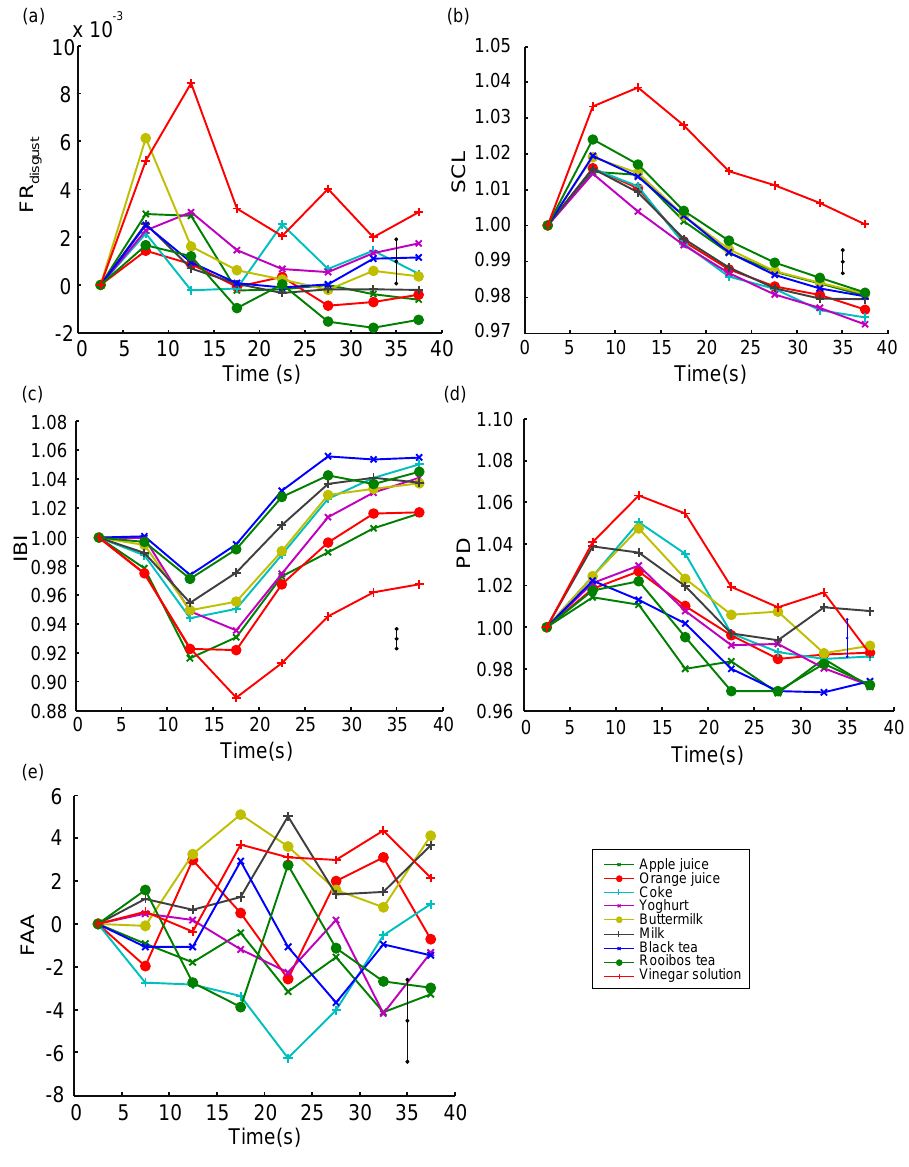
Figure 6. The continuous behavioral measure FR disgust ( a ) and the physiological measures SCL ( b ), IBI ( c ), PD ( d ), and FAA ( e ) plotted over time from the time that the name of the drink appeared (t = 0 s) to just before the rating scales appeared (t = 40 s), averaged across participants and separately for each